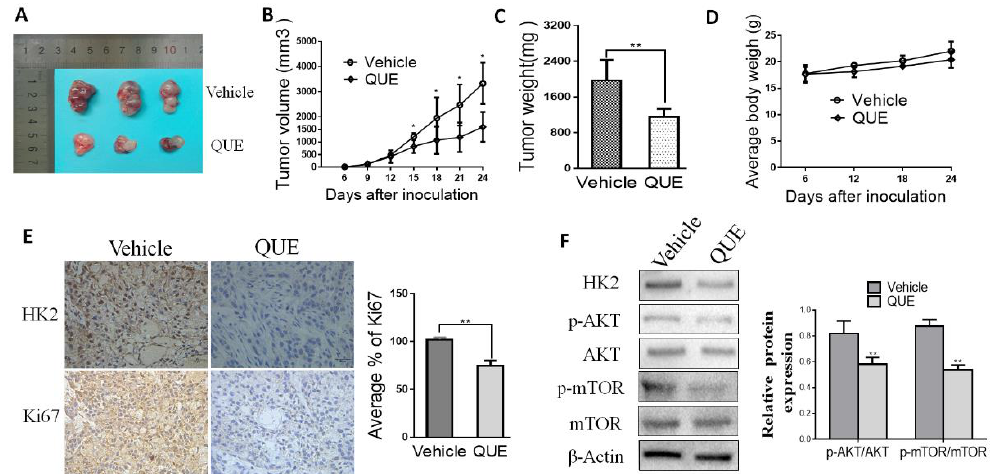
Figure 4. QUE inhibits tumor growth in SMMC-7721 xenograft mouse models. Nude mice with SMMC-7721 xenograft were randomly divided to groups and then 50 mg / kg QUE was administrated. The tumor area was measured every 3 days and the tumor volume and tumor weight was calculated as described in Materials and Methods. ( A ) photograph of tumors in vehicle and QUE-treated group; ( B ) tumor growth curve in vehicle and treated group; ( C ) tumor weight in vehicle and QUE group; ( D ) during the treatment period, the body weight of mice was measured once a week to determine the e ff ect of QUE. ( E ) Immunohistochemical staining examination of Ki67 and HK2 in tumor sections from vehicle or QUE treated group. All panels are of the same magnification. The histogram on the right represents the average percentage of Ki67 expression. ( F ) Expression of HK2, Akt and phosphorylated Akt, mTOR and phosphorylated mTOR in harvested tumors. The tumors lysates were harvested and phosphorylation of indicated proteins was detected by western blotting. β -Actin were used as internal standards ( * P < 0.05; ** P < 0.01 vs. Vehicle ).